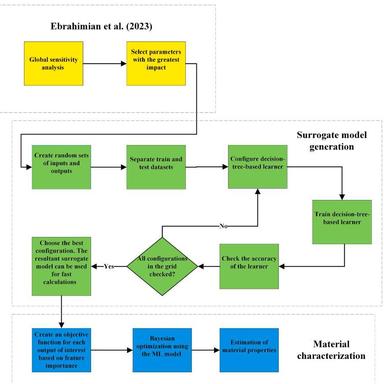
Workflow of the creation of ML models and parameter estimation. In the first step, we used the global sensitivity analysis results from our previous work to find the most important parameters in the middle-ear model). We then created some random sets of inputs for these parameters using the mean values equal to respective values in the baseline model and the ranges reported in (with uniform distribution). In total, we had 1050 FE simulations and the size of our training and testing